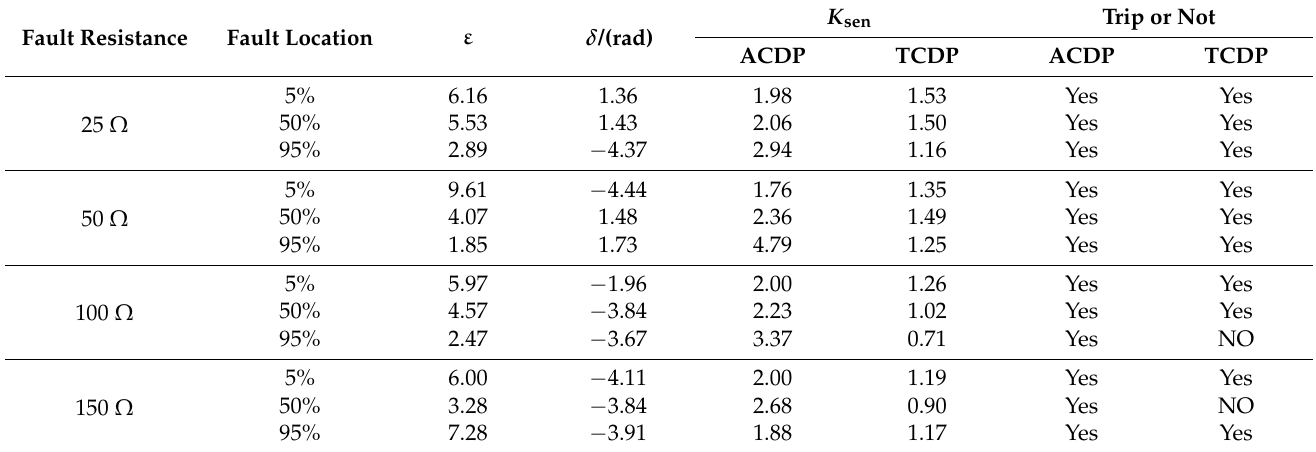
Table 5. Simulation results of ABg faults with high fault resistance at feeder B 5 B 6 .